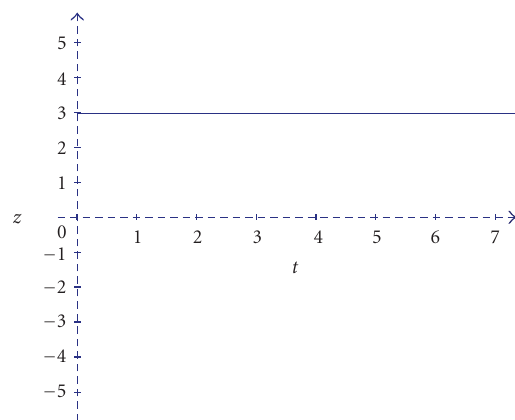
Figure 6.10 . Bounded solution of (5.2) in the point M (40,40), a 0 = 3.